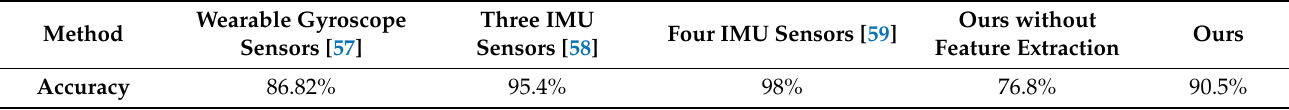
Figure 9. The joint characteristics and motion recognition results of different sub-actions. ( a ) shows the trend of change in elbow angle and knee stick in the DP action. ( b ) shows the change trend of elbow angle and knee stick in the DS action. ( c ) shows the change trend of the elbow angle and knee stick in the DT action. ( d ) shows the motion recognition results of different sub-actions. Table 6. Motion recognition accuracy of different methods.